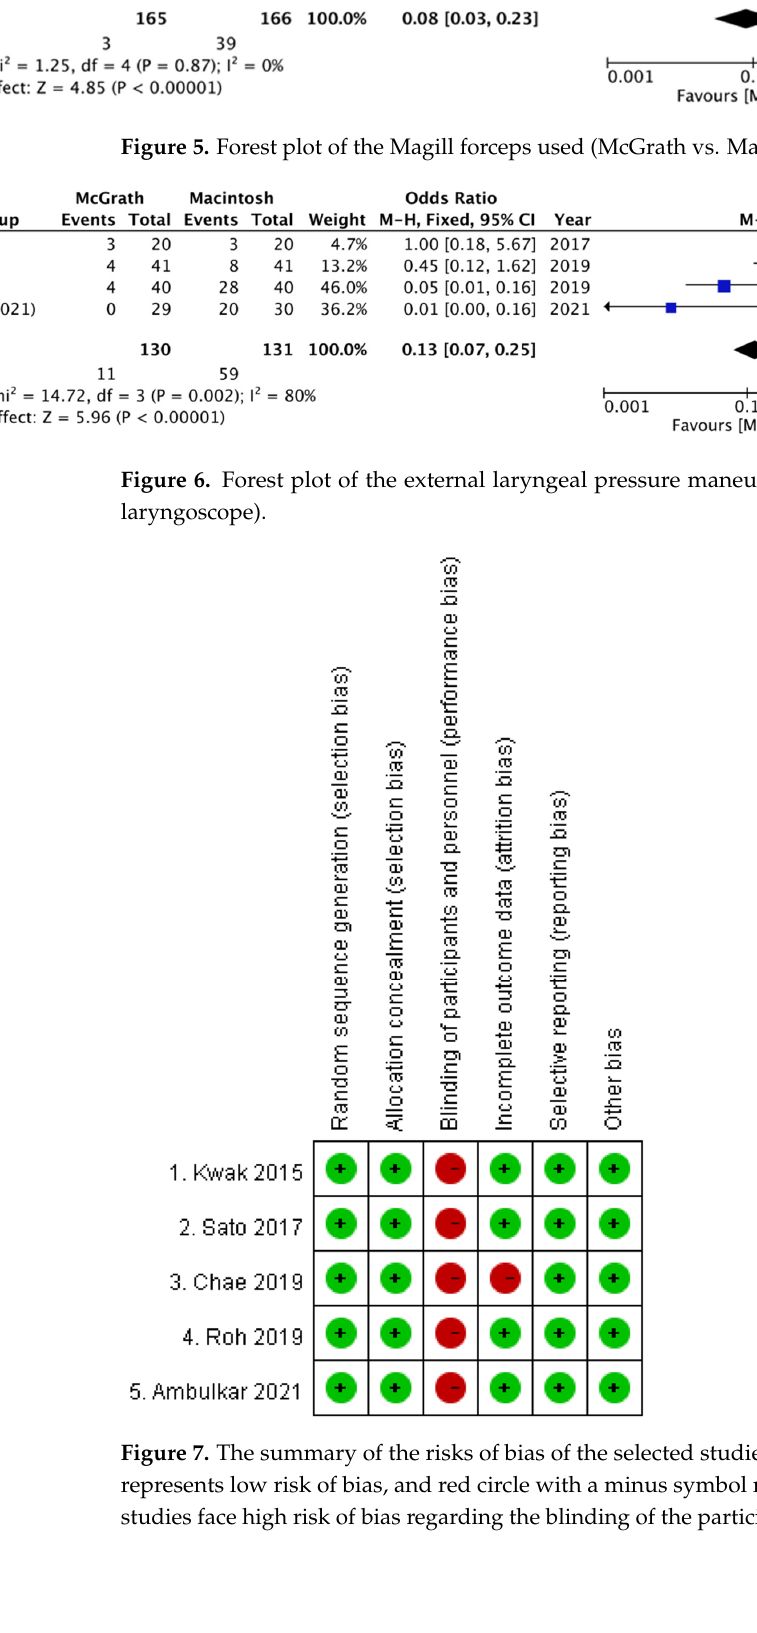
Figure 7. The summary of the risks of bias of the selected studies. Green circle with a plus symbol represents low risk of bias, and red circle with a minus symbol represents high risk of bias. All the studies face high risk of bias regarding the blinding of the participants.